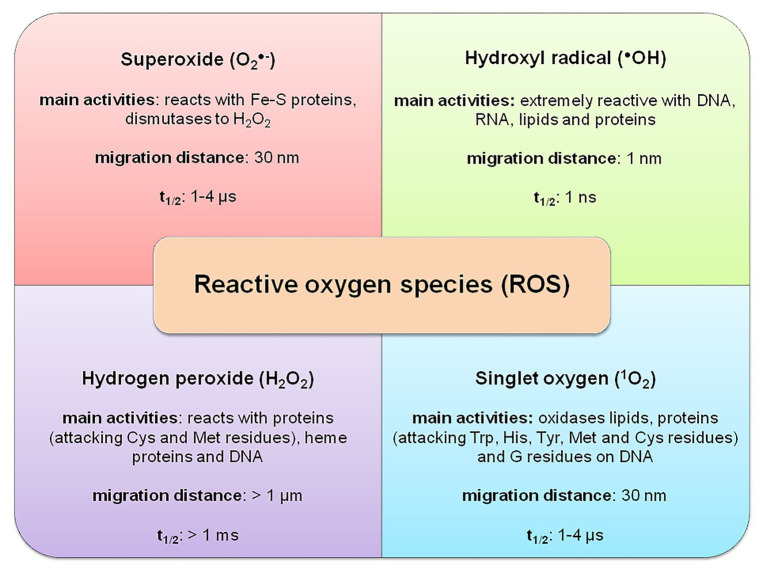
Basic properties of reactive oxygen species (ROS) in a plant cell – adapted from: Mittler (2017; https://creativecommons.org/licenses/by-nc-nd/4.0/).